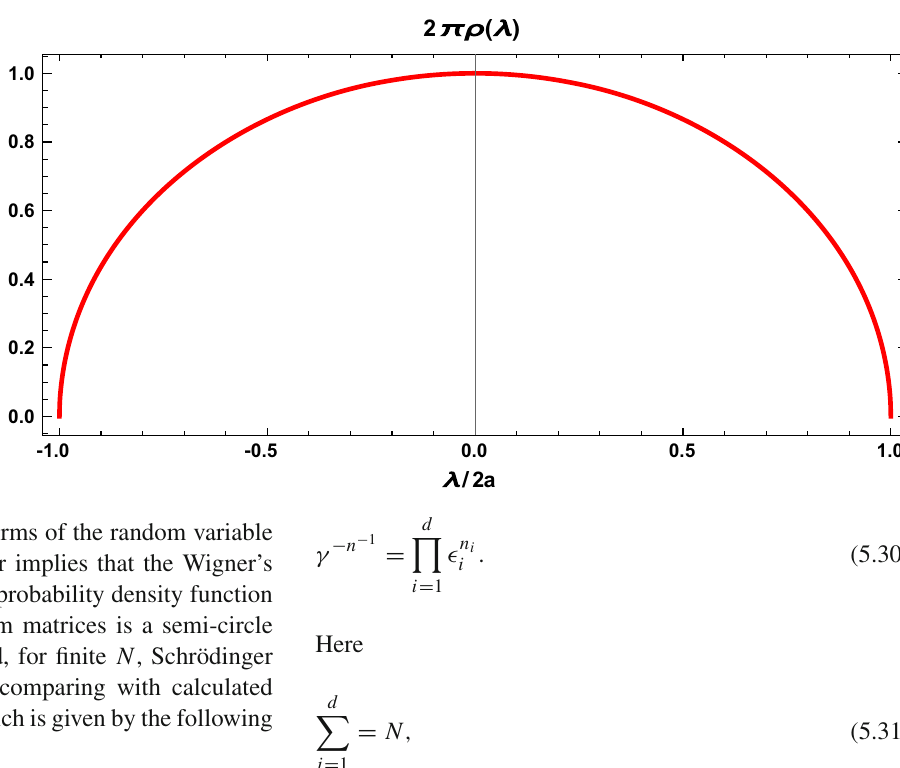
Fig. 22 Schematic representation of Wigner semicircle law for Gaussian random matrices